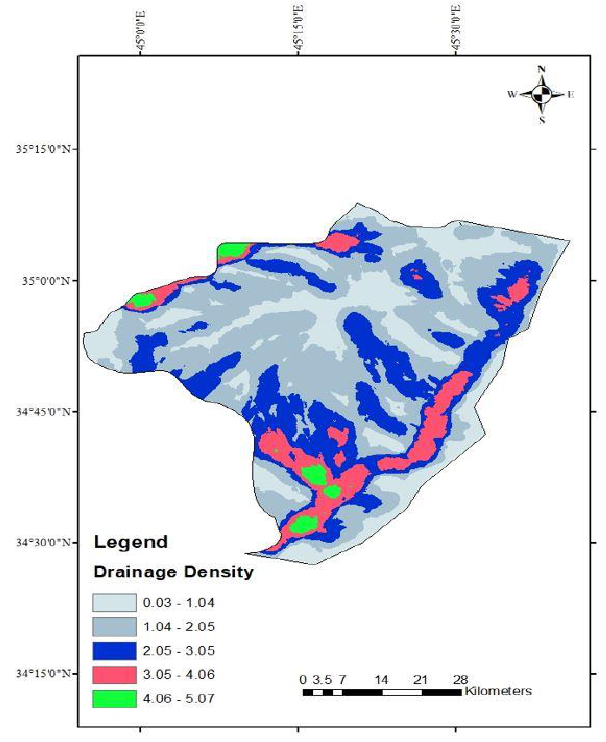
Figure 9. Drainage density map of study area.